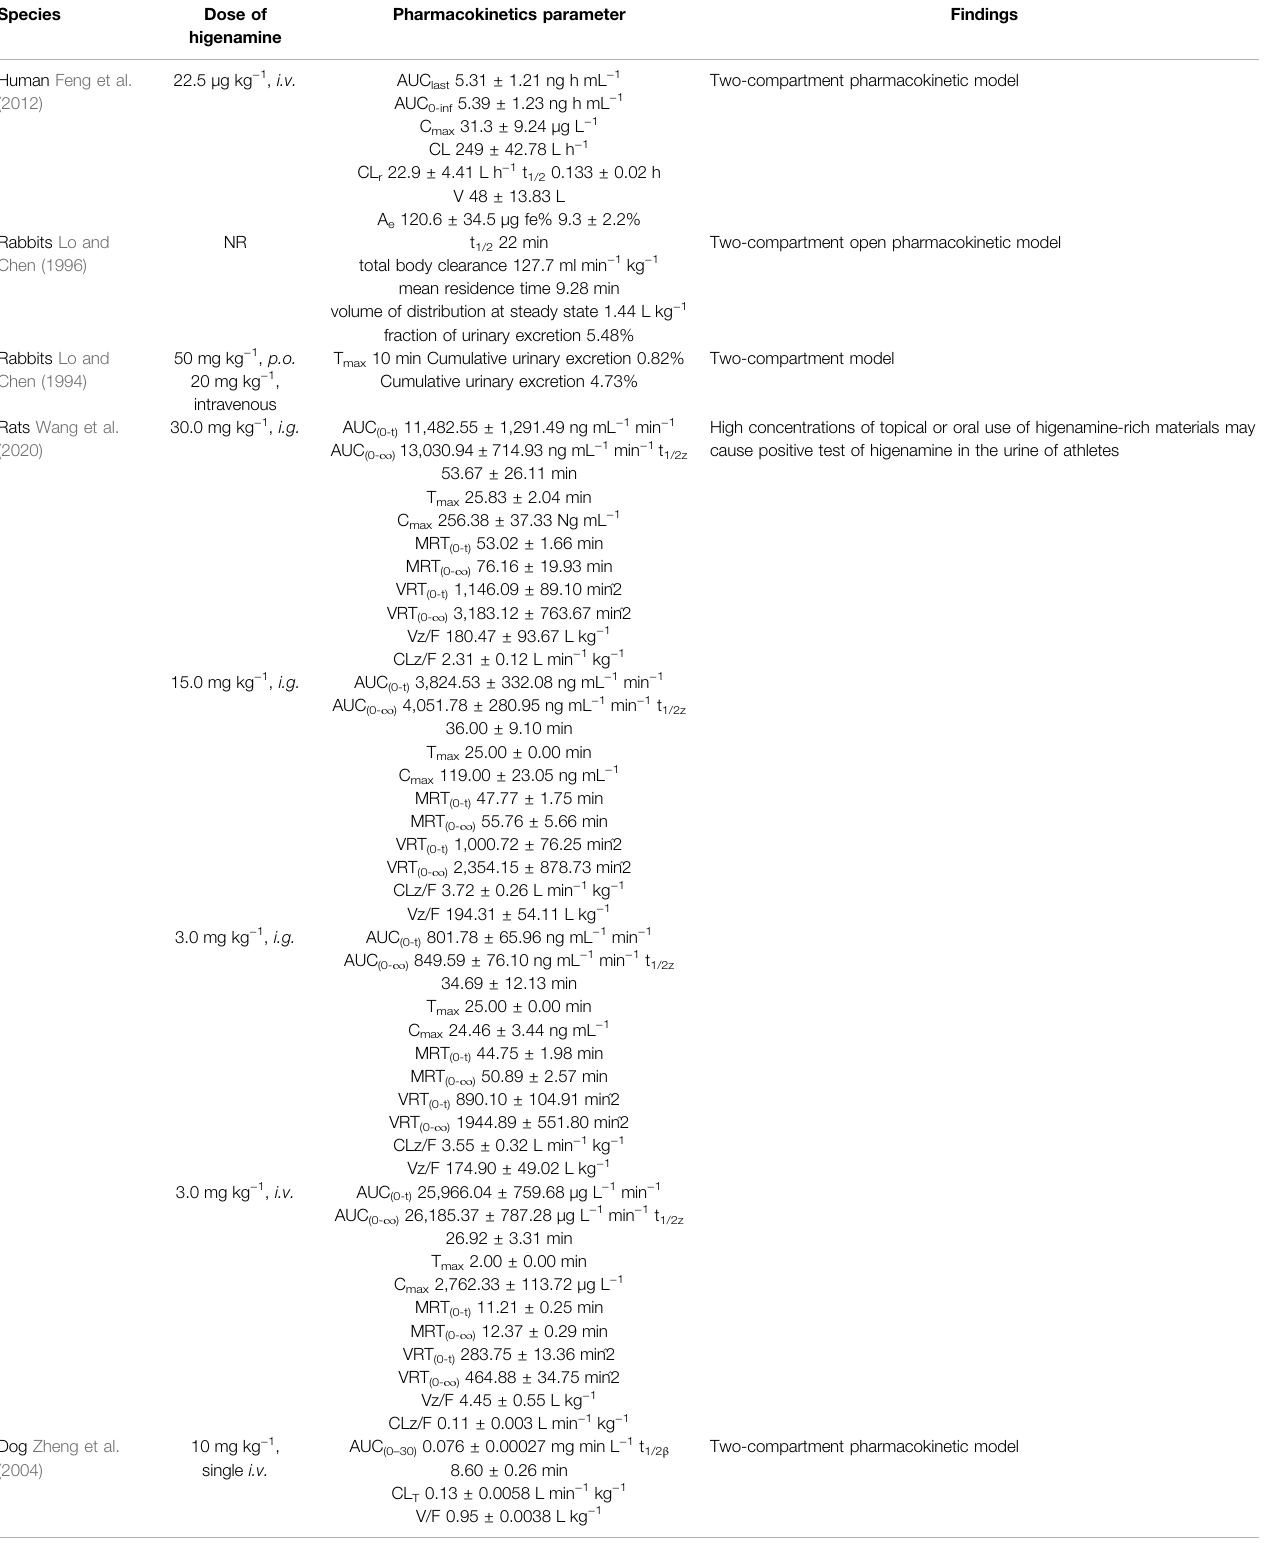
TABLE 1 | Pharmacokinetics parameters of higenamine in different kinds of animals. Species Dose of Pharmacokinetics parameter Findings higenamine Human Feng et al.